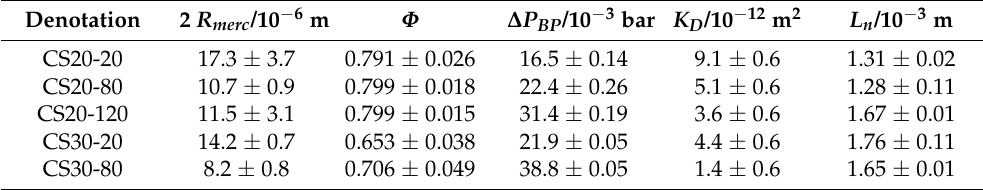
Figure 7. Hg intrusion porosimetry diagram for samples with 30 wt% of solid loading for different temperatures of freezing. Dashed lines indicate the biggest pore window size calculated based on the bubble point pressure D BP . Table 3. Geometric and macroscopic parameters of the ceramic